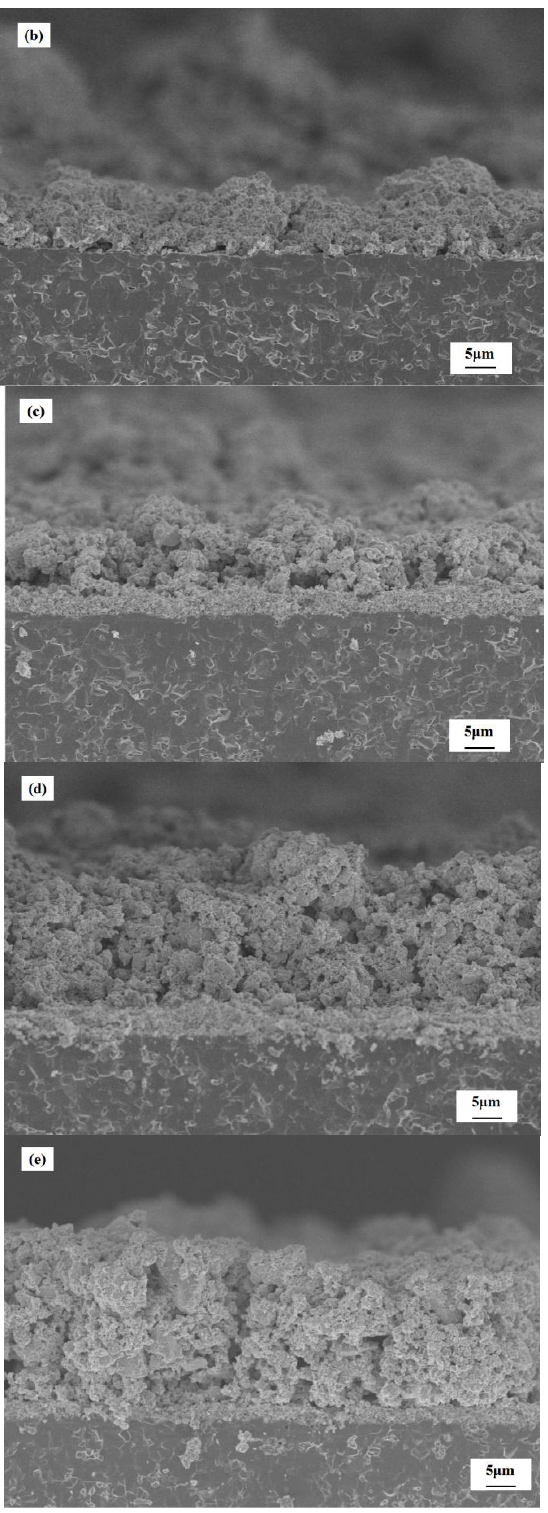
Figure 10. SEM images of the cross-section of the gas sensors: ( a ) S(c); ( b ) S(m); ( c ) S(c/m1); ( d ) S(c/m2); and ( e ) S(c/m3).